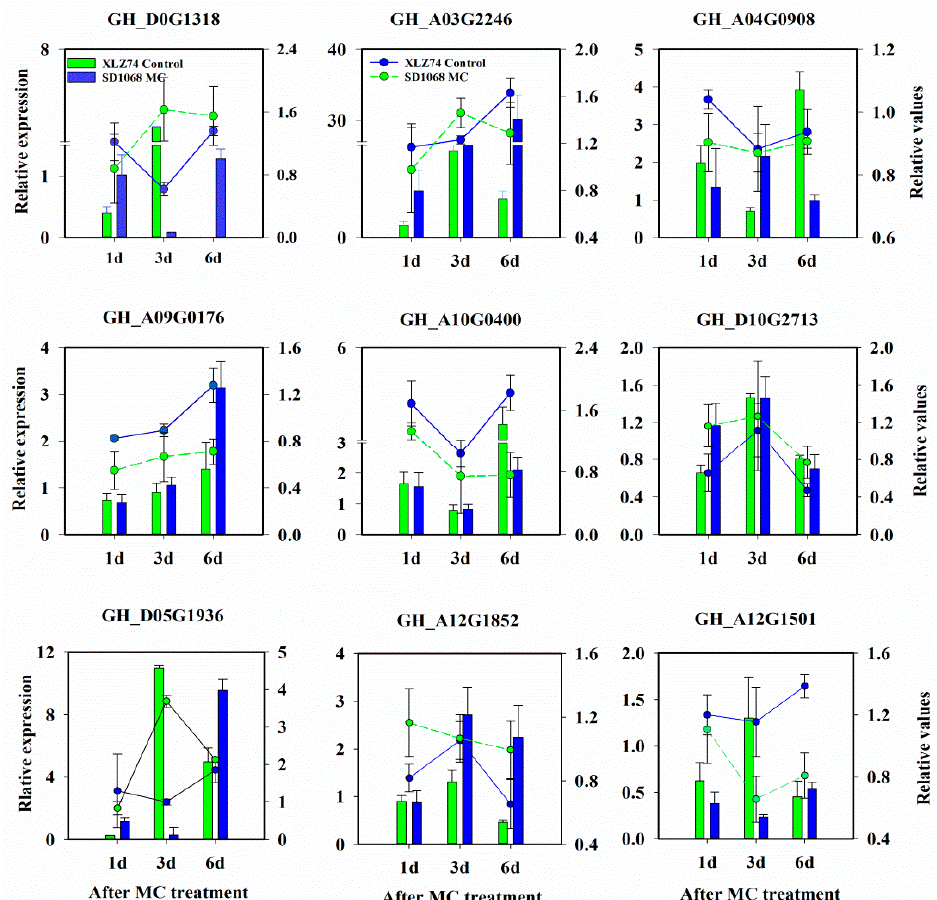
Figure 2. qRT-PCR validation of the RNA-seq results of 9 randomly selected genes. Y-axis represents the relative expression level based on qRT-PCR (displayed as columns) and relative values (the ratio of FPKM between MC and Water treatment, displayed as lines) of the gene shown on top of the graph. Error bars represent the SD of three biological replicates.